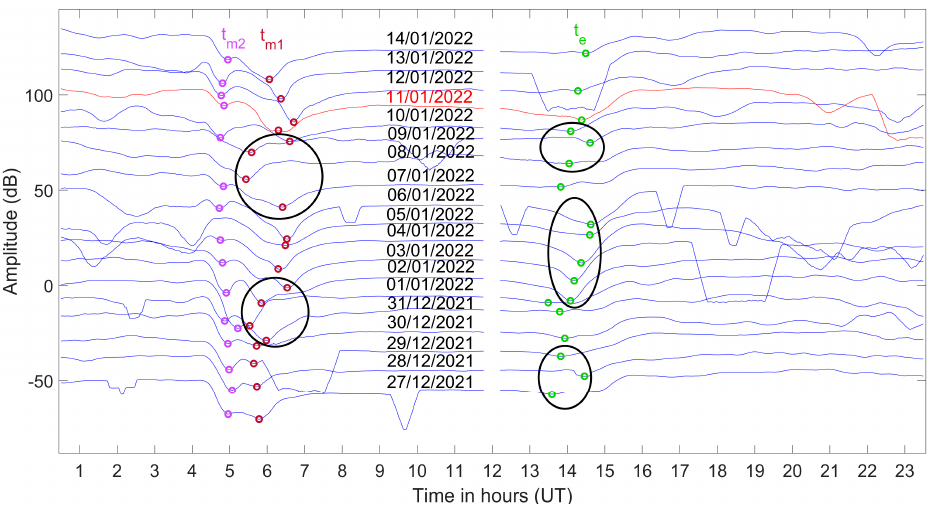
Figure 5. Diurnal variation of the amplitude of the VLF signal of the propagation path GER–ISR for the time period 27 December 2021–14 January 2022. Each signal is vertically shifted by +10 dB in regards to the signal of the previous day. Brown and purple circles indicate the minima identified as morning TTs before and after the sunrise, respectively. Green circles are the evening TTs, which appear before the sunset. Finally, the date of the EQ is marked with red color. The black circles indicate the existence of shifts of